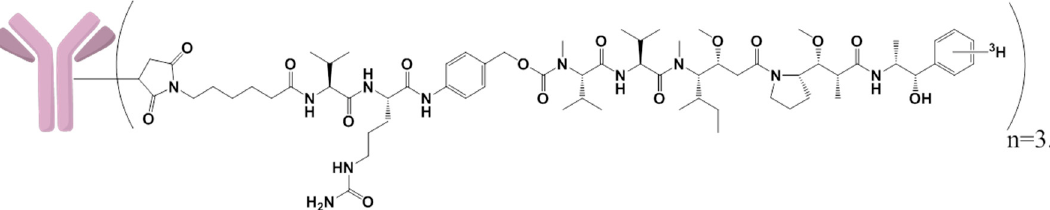
Figure 1. Structure of [ 3 H]-monomethyl auristatin E (MMAE)-polatuzumab vedotin (drug-to-antibody ratio (DAR) of 3.4) and the location of the radiolabeled 3 H on the MMAE.